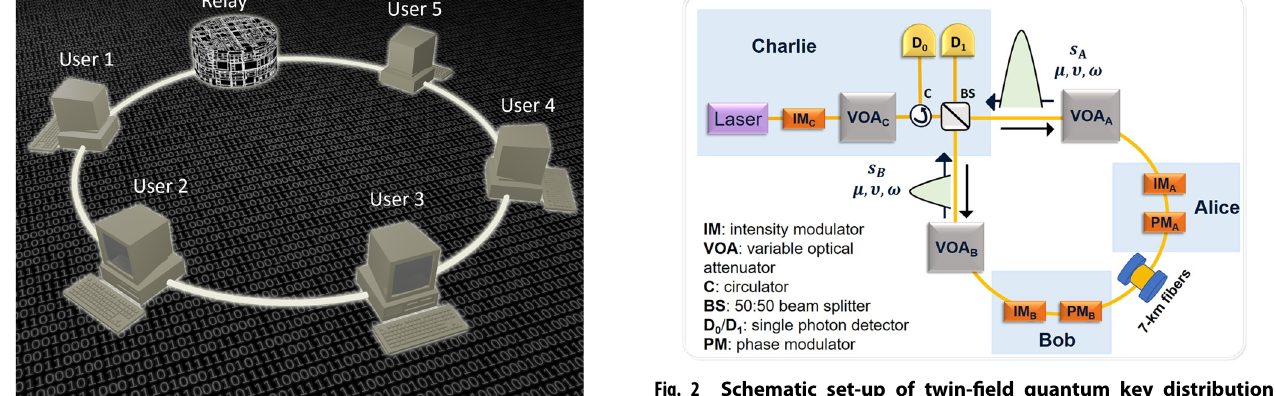
Fig. 2 Schematic set-up of twin- fi eld quantum key distribution (TFQKD) over optical channels with asymmetric losses. Charlie produces un-modulated weak coherent pulses through his intensity modulator (IM C ) and variable optical attenuator (VOA C ) and distributes the pulses to Alice and Bob. The pulses enter the Sagnac loop through a circulator and a 50:50 beam splitter (BS) where they split into clockwise and counter-clockwise traveling pulses. The clockwise traveling pulses fi rst pass through the attenuator VOA A and Alice ’ s station without being modulated. Then they go through a 7-km fi ber spool and arrive at Bob ’ s station. Based on the bases Bob chooses (signal basis or decoy basis), he modulates the phases and intensities of the pulses by his phase modulator and intensity modulator. Then Bob forwards the modulated pulses back to Charlie ’ s BS though the attenuator VOA B . The same process applies to the counter-clockwise traveling pluses, except that only Alice would modulate the phases and intensities of the counter- clockwise traveling pulses. The modulated pulses from Alice and Bob interfere with each other at Charlie ’ s BS and are detected by Charlie ’ s two single-photon detectors D 0 and D 1